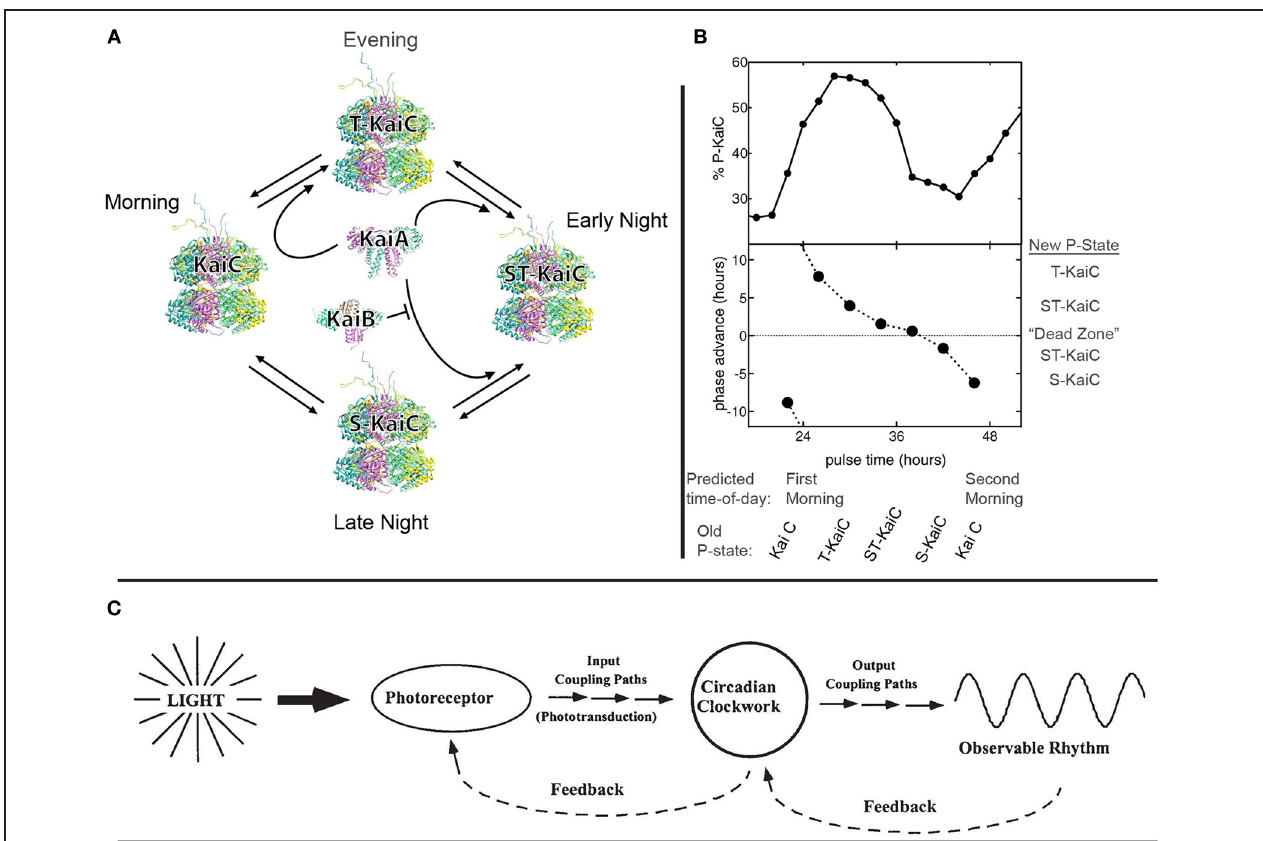
FIGURE 1 | Basic architecture and dynamics of circadian biocognition in cyanobacterium S. elongatus PCC 7942. (A) The p-rhythm of KaiC constitutes the central pacemaker or “clock.” In the morning, KaiC is unphosphorylated; this p-state is here labeled as “KaiC” at left. As the day progresses toward evening, KaiA promotes the phosphorylation of KaiC at residue Threonine 432, forming p-state “T-KaiC” at top. Throughout the early night, KaiA biases T-KaiC toward further phosphorylation at residue Serine 431, forming doubly-phosphorylated “ST-KaiC,” at right. In late night, ST-KaiC begins to dephosphorylate at Threonine 432, forming “S-KaiC” at bottom. KaiB then binds to S-KaiC and inactivates the phosphorylation enhancement of KaiA, and KaiC returns to the unphosphorylated state (at left) on the next day’s morning. This same cycle occurs with circadian rhythmicity in the absence of a Zeitgeber . [This panel modified from Dong et al. (2010) Figure 1 with permission from Elsevier]. (B) The endogenous p-rhythm of KaiC is directly entrained by altering the relative abundance of phosphate groups available to phosphorylate KaiC. The X-axis depicts the clock’s predicted time-of-day, and the corresponding p-state of KaiC (as described in (A) above). The top panel depicts > 1 day of circadian KaiC phosphorylation rhythms in the absence of Zeitgebers (first predicted morning just prior to “24h” second predicted morning prior to “48h”). The bottom panel shows the phase-dependent recalibration of KaiC p-rhythms, induced by providing a “pulse” of ADP, which depletes the relative abundance of free phosphate groups (by decreasing the ATP to ADP ratio). Recalibration occurs as an alteration of the p-state of KaiC, which encodes a new prediction regarding time-of-day. The corresponding “new”